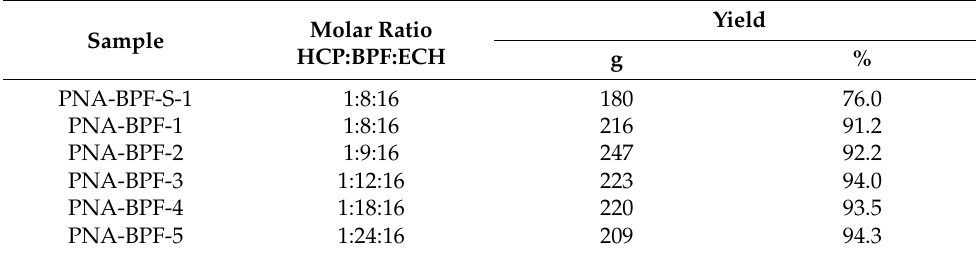
Table 5. Yield of the obtained PhER.